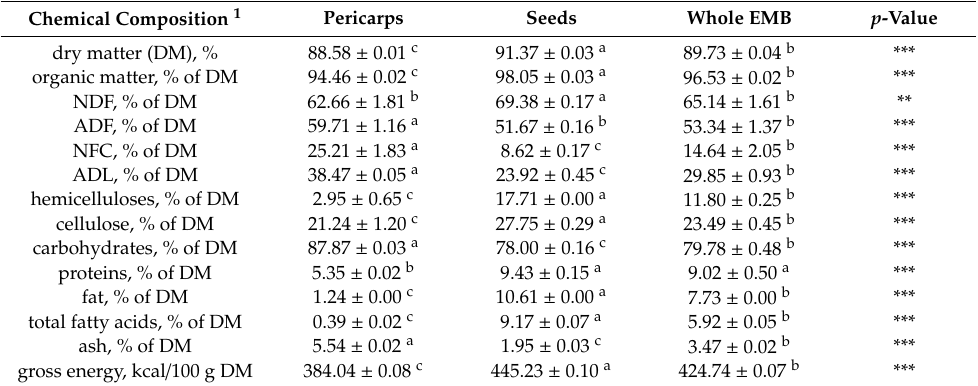
Table 1. Chemical composition of seeds, pericarps and whole exhausted myrtle berries. Chemical Composition 1 Pericarps Seeds Whole